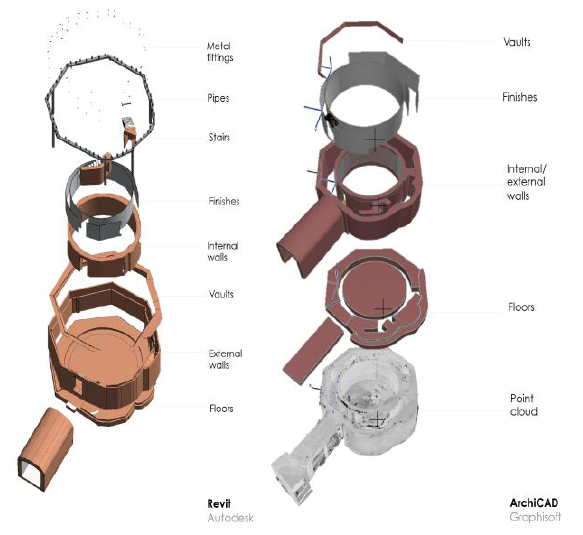
Fig. 10. Exploded view of Revit BIM (left); and ArchiCAD BIM